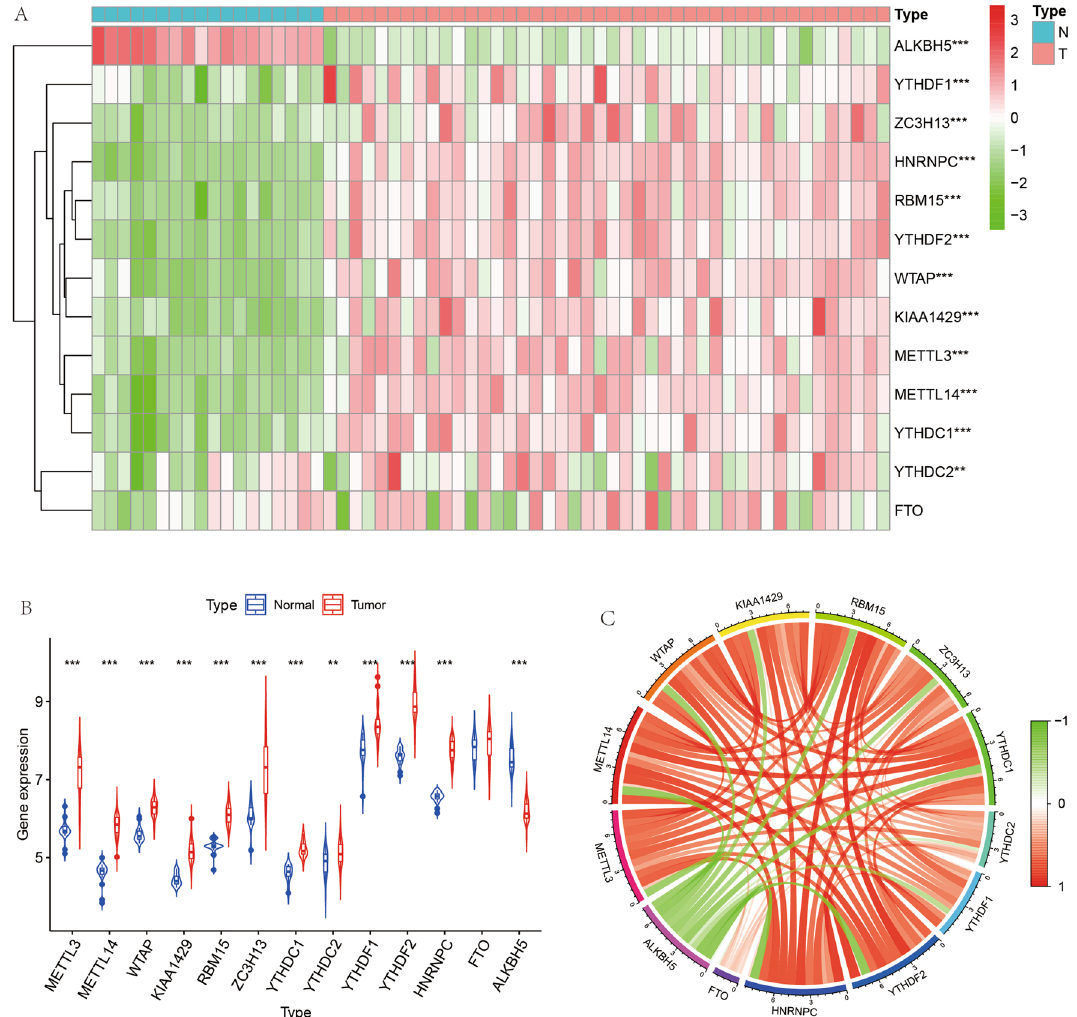
Figure 3. Heat map, violin map and correlation circle map of m6A-related genes. ( A ) shows a heat map of differential expression of m6A-related genes, with red indicating highly expressed genes and green indicating lowly expressed genes. ( B ) represents the expression of m6A-related genes in paraneoplastic tissues and in Ewing’s sarcoma. Figure C represents the correlation plot between m6A-related genes, with the linkage between quantitative genes in red for synergistic high expression and in green for synergistic low